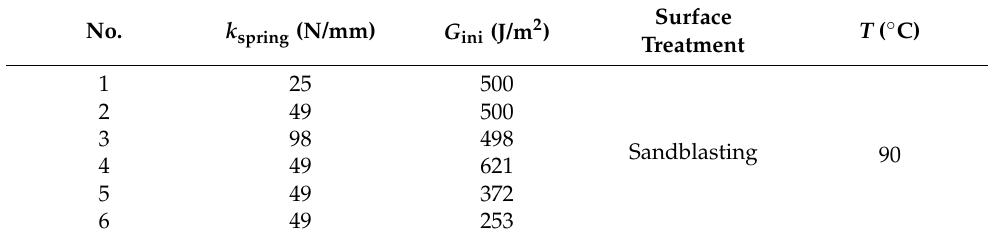
Table 1. Experimental conditions for studying the effects of the spring constant and initial energy release rate.